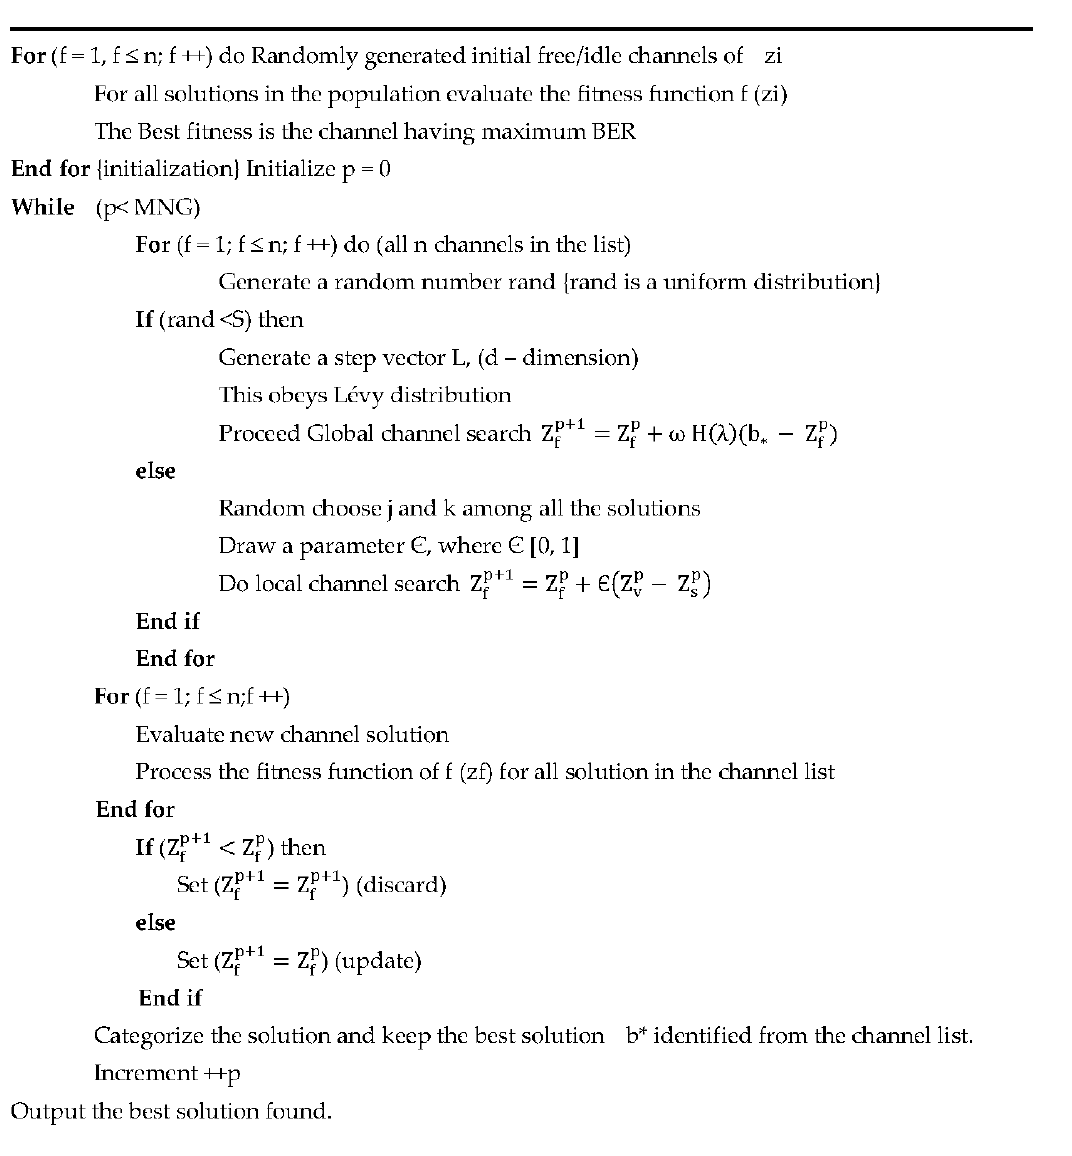
Figure 6. Pseudo code of the proposed Enhanced Flower Pollination-based Optimized Channel selection (EFPOC) algorithm.